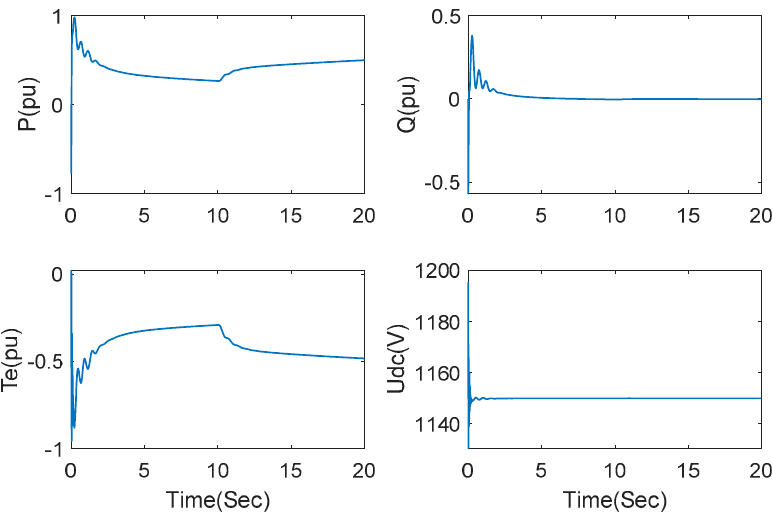
Figure 6. Responses of active power, reactive power, electromagnetic torque, DC link voltage with no series ‐ compensated capacitors.